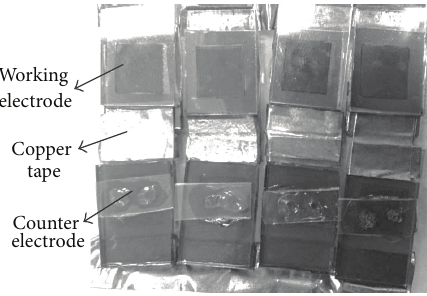
Figure 3: Real diagram of DSSC module assemblies.